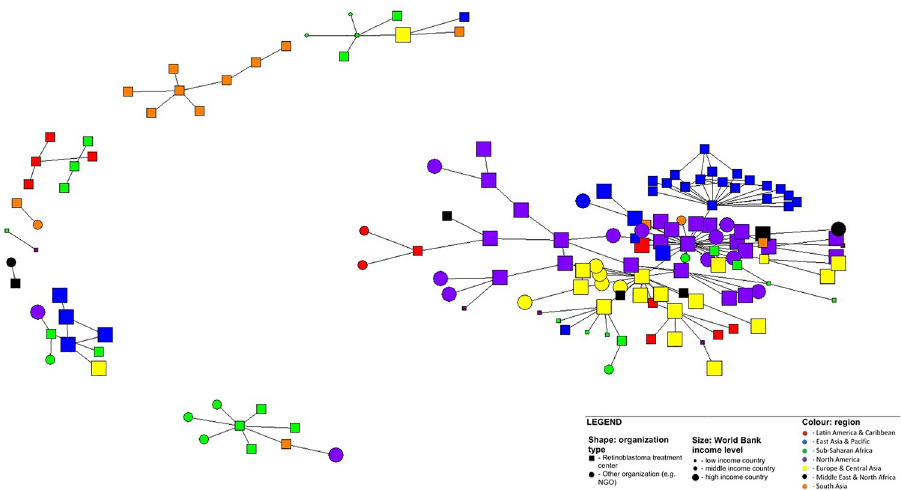
Fig 1. Network diagram for all collaborative activities. Network diagram depicting 56 egos and 112 unique alters connected by 183 collaborative activities (ties).